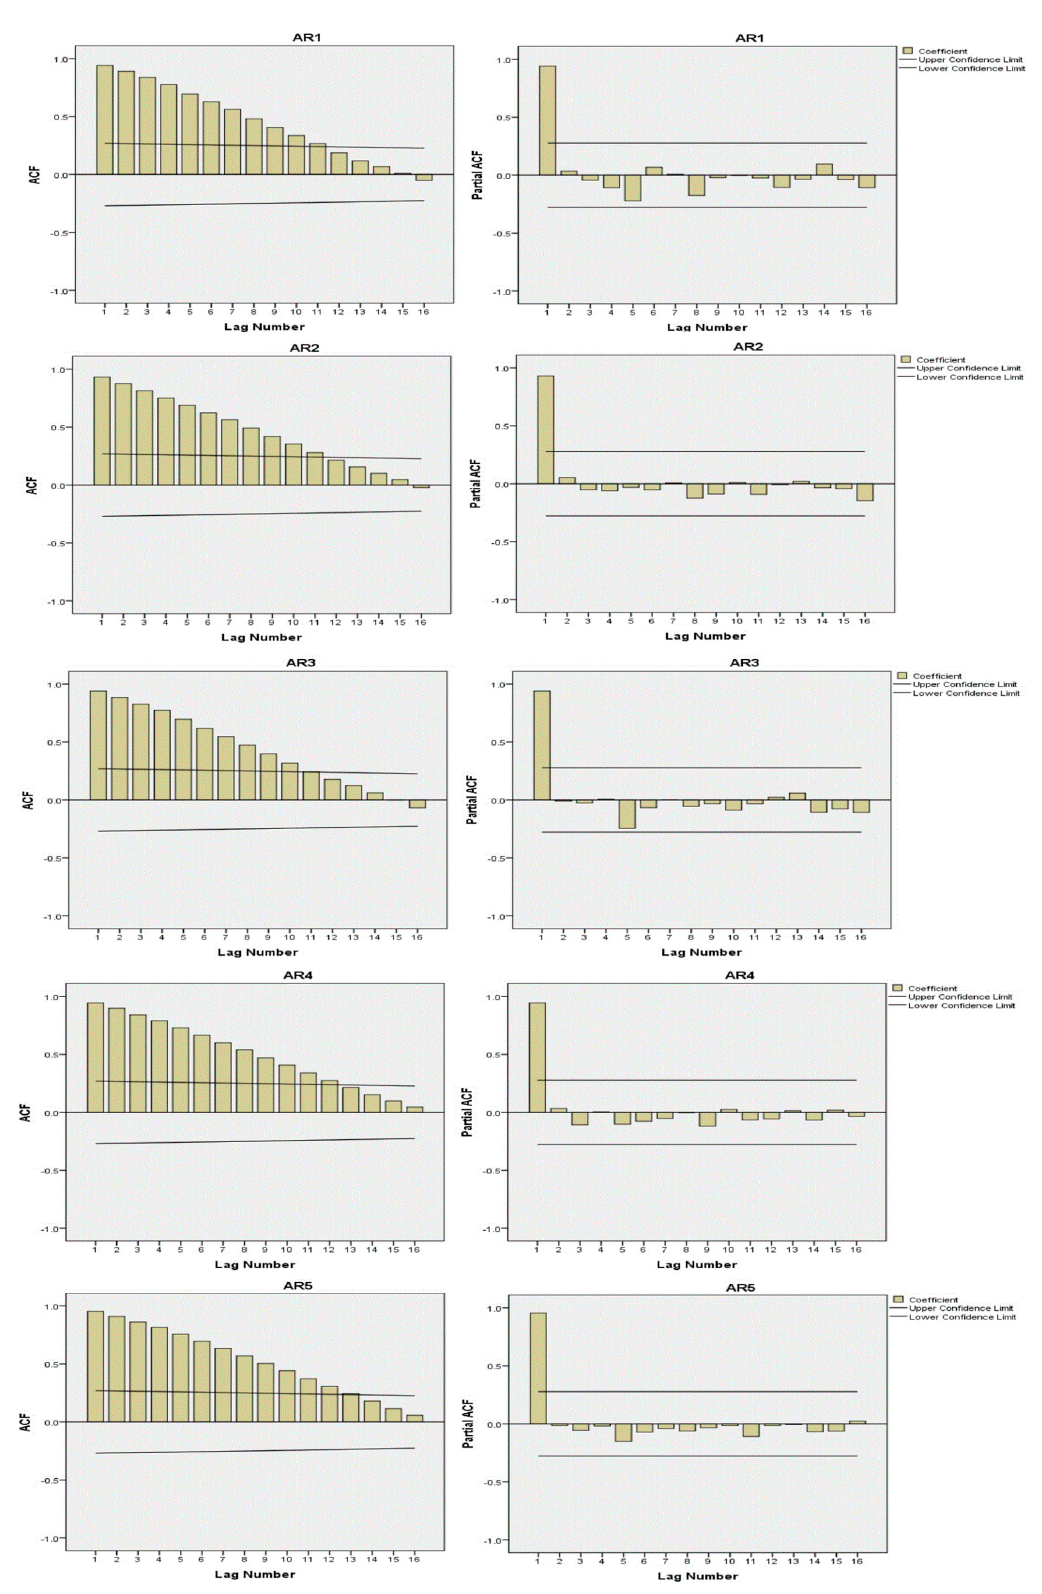
Figure 5. Sample autocorrelation function (ACF) (left panels) and sample partial autocorrelation (PA).